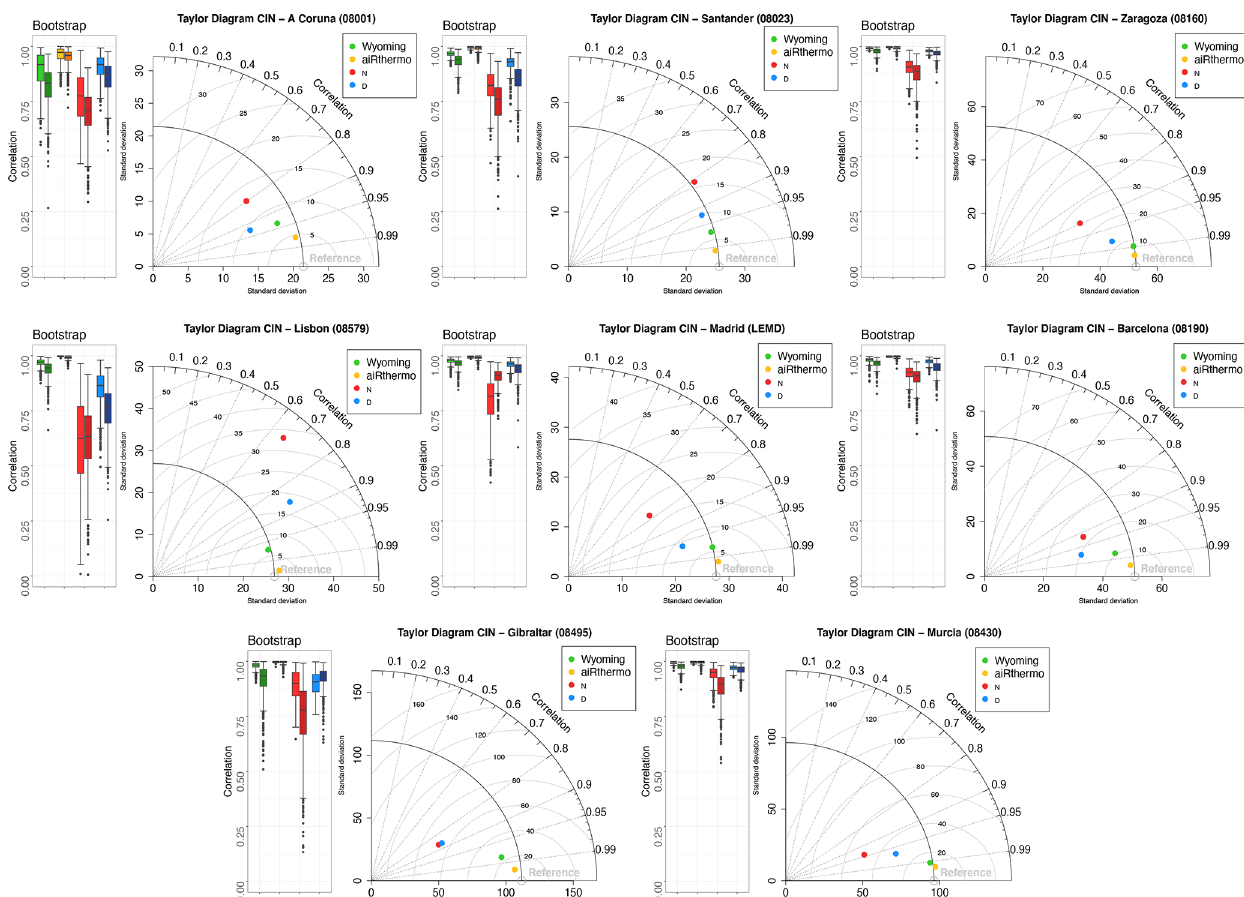
Figure 4. Same as Figs. 2 and 3 but for